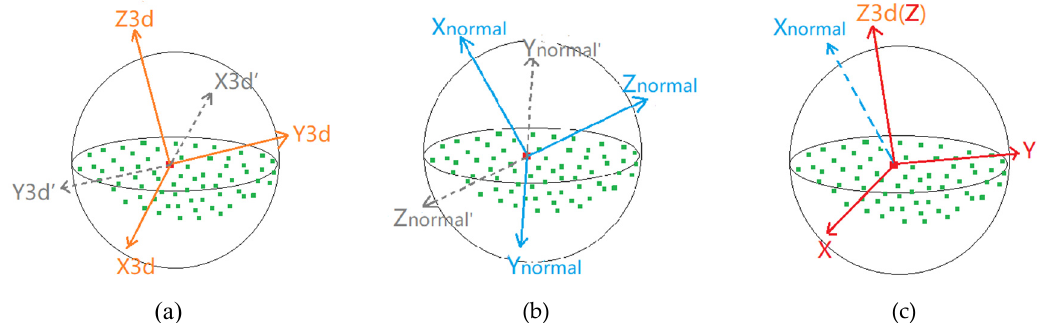
Figure 4. Local-reference frame (LRF) construction. ( a ), ( b ) are, respectively the LRF constructed by coordinate covariance matrix and normal vector covariance matrix, ( c ) is the proposed LRF combining coordinate and normal vector covariance.